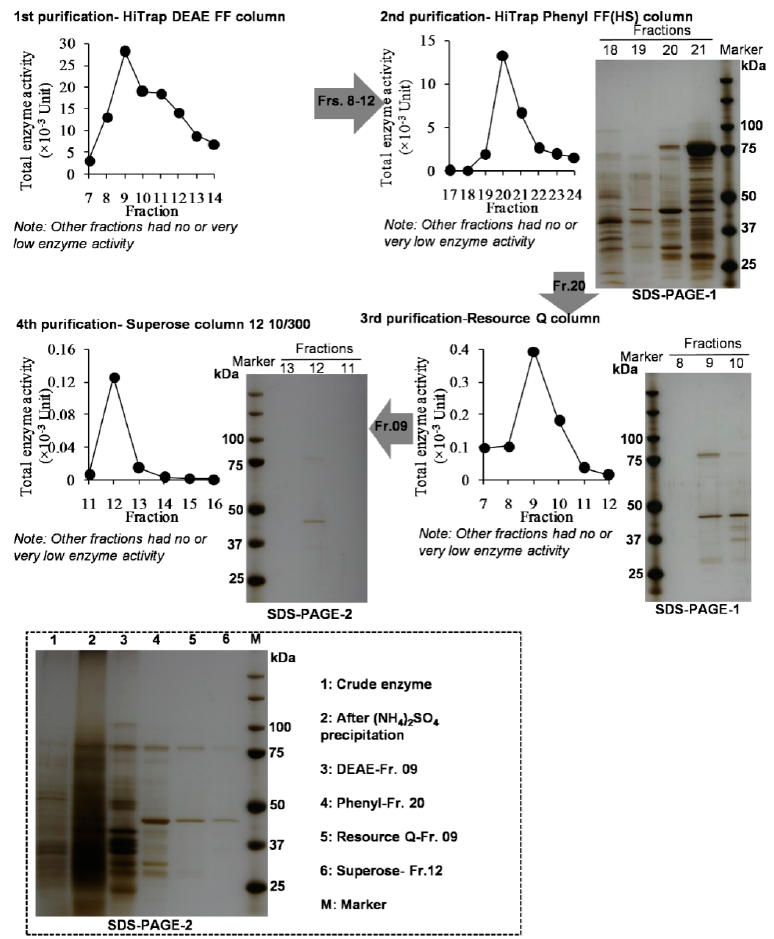
Figure 1. Isolation, partial purification, and SDS-PAGE identification of the enzymes involved in the pathway leading acetophenone to 1PE. Here the unit represented total enzyme activity.